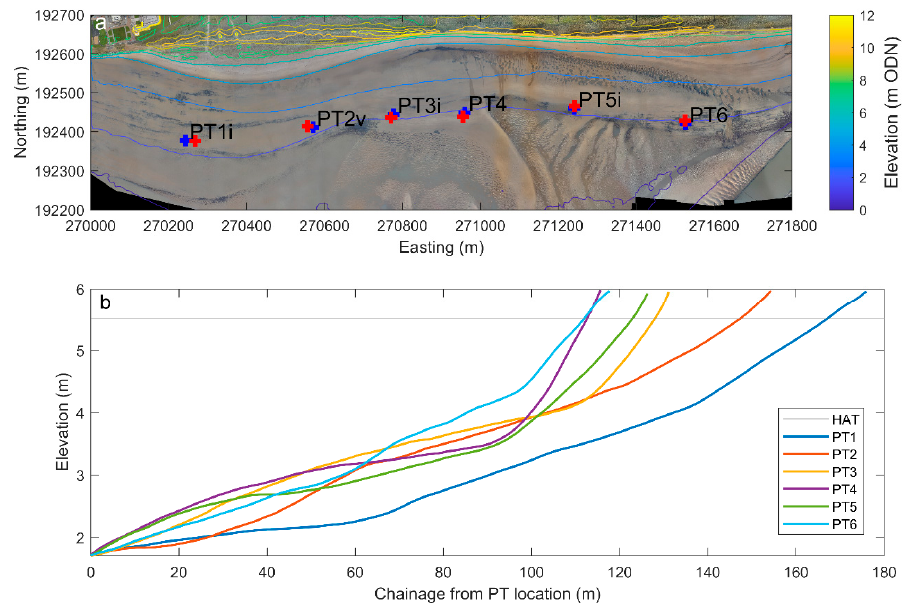
Figure 6. ( a ) Locations of the six pressure transducers for deployment 1 (blue) and deployment 2 (red) overlain on an orthomosaic of the site with coloured contours showing the mean beach surface elevation; ( b ) cross-shore profiles of the mean beach surface from the location of each PT to an elevation of 6 m ODN.